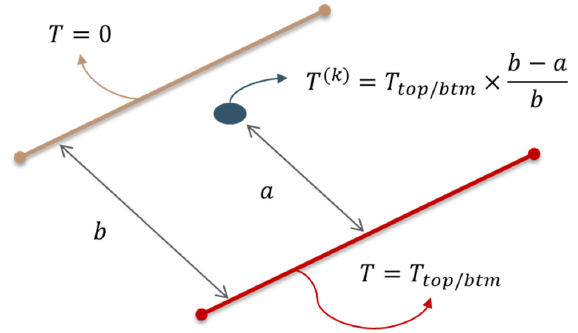
Figure 6. Temperature boundary conditions imposed on the shell element.